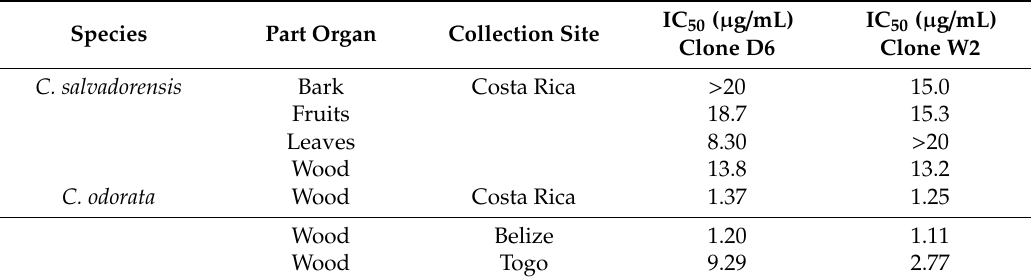
Table 11. The half maximal inhibitory concentration (IC 50 ) values for Cedrela active species extracts obtained in the table presented by MacKinnon et al.